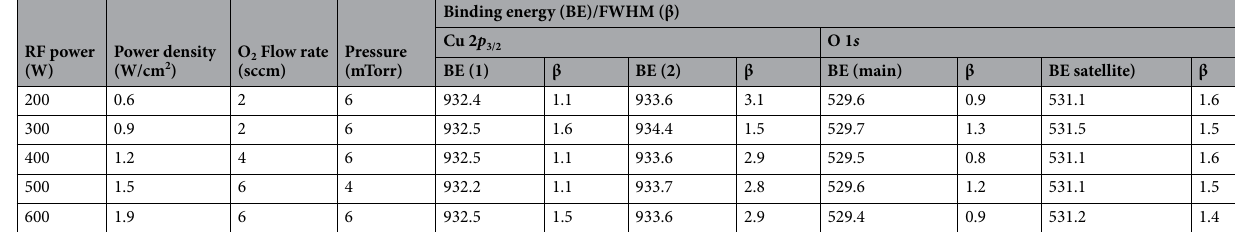
Table 3. Extract of XPS binding energies (BE) and full width at half-maximum (β) of oxide films in the de-convoluted Cu 2 p 3/2 and O 1 s core level regions.